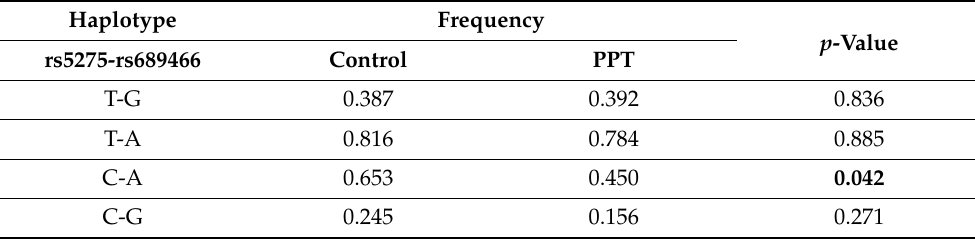
Table 4. Haplotype association analysis between controls and PPT